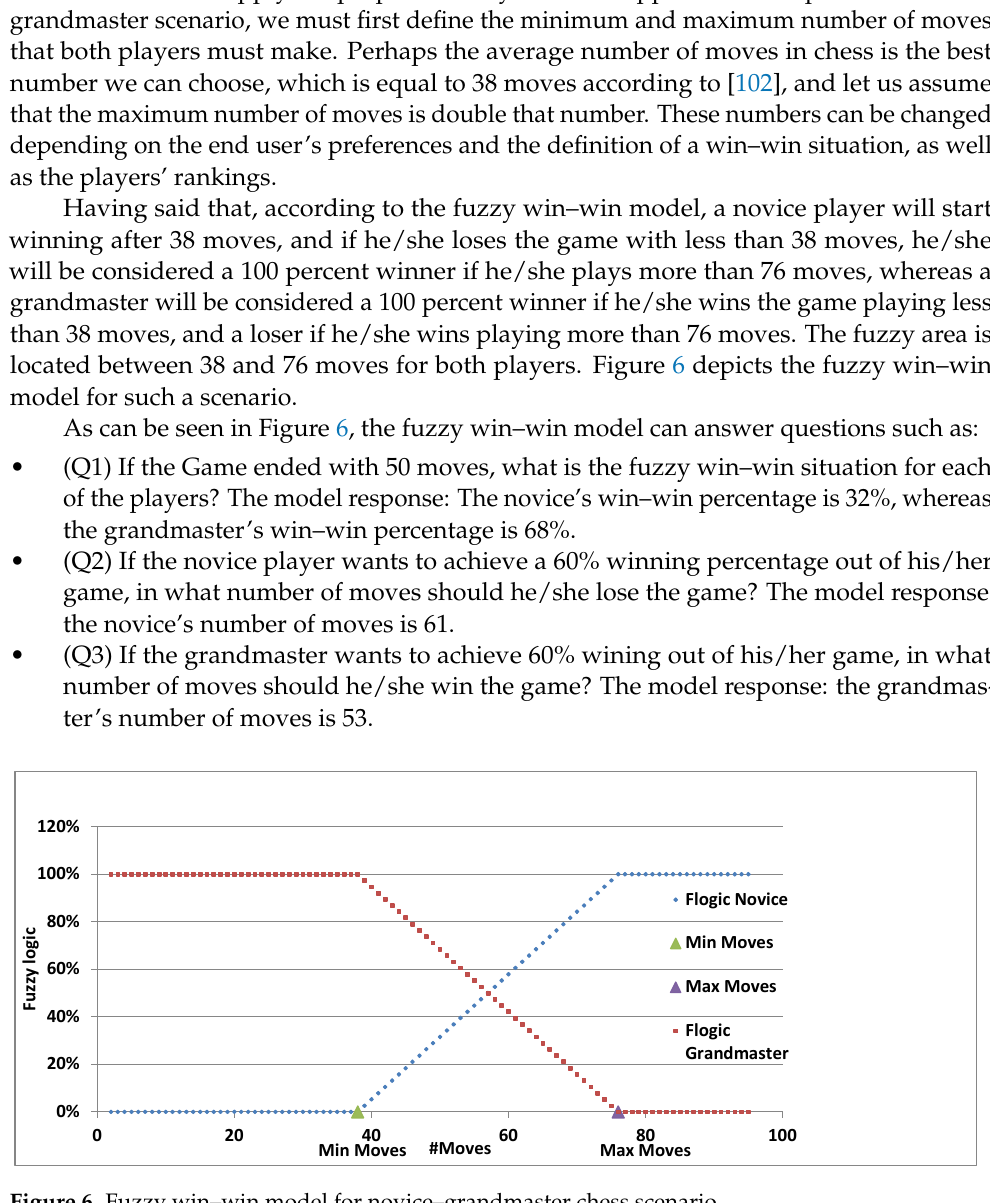
Figure 6. Fuzzy win–win model for novice–grandmaster chess